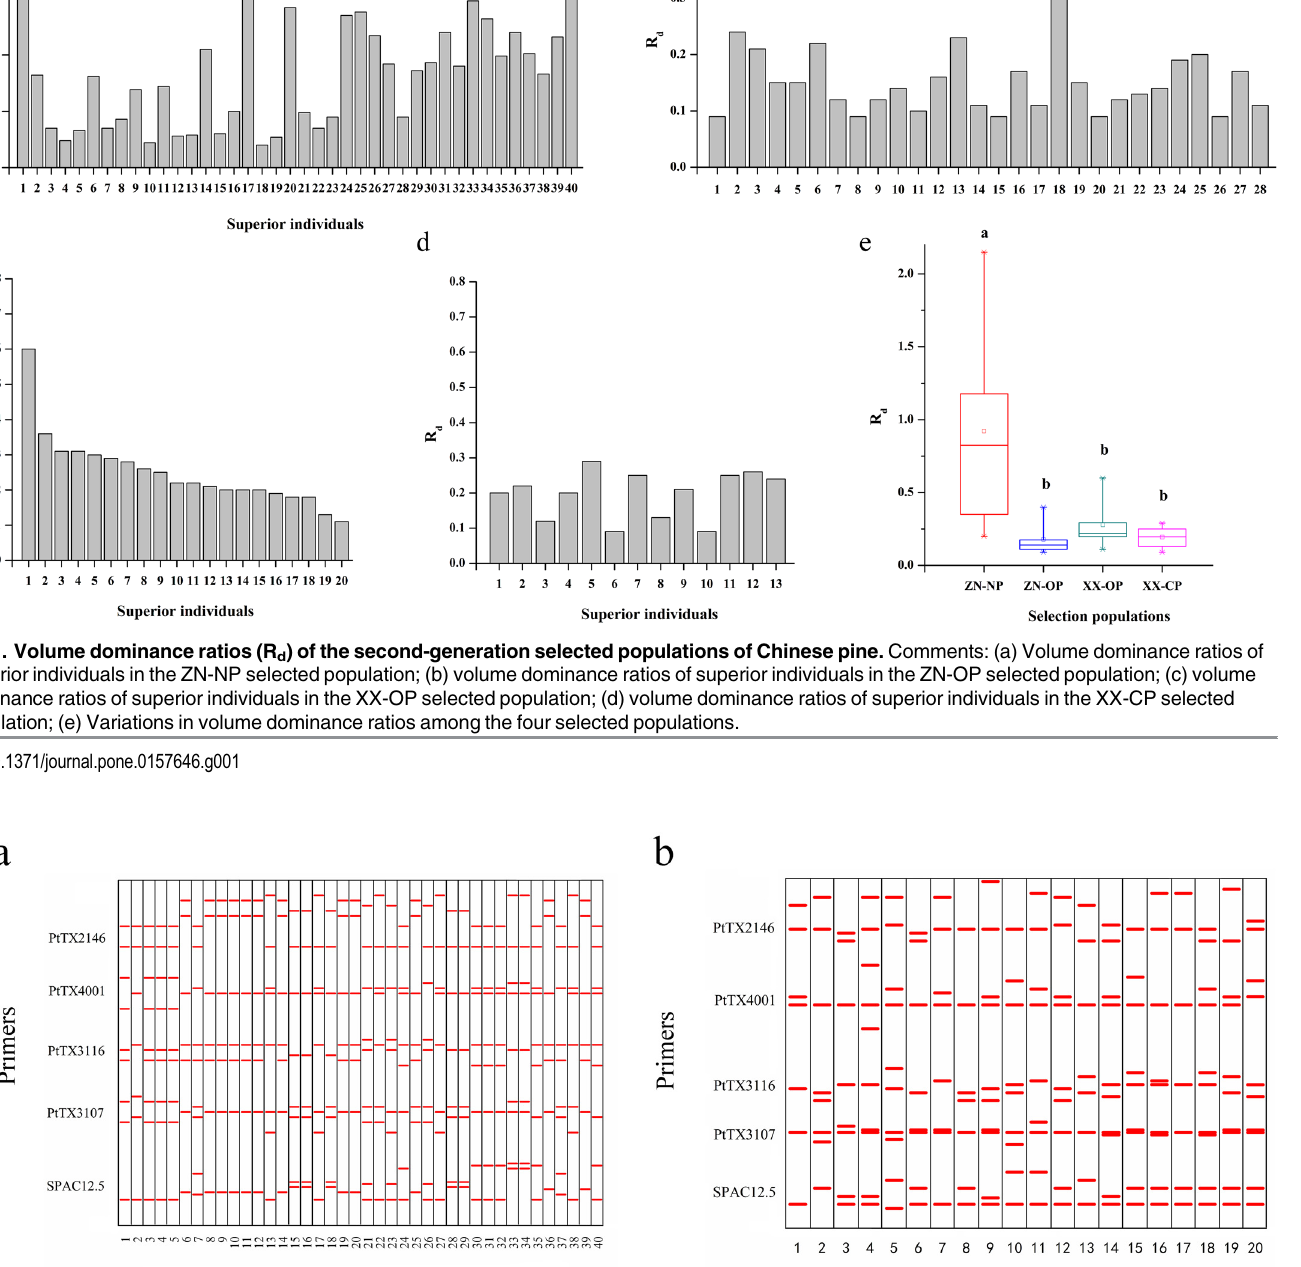
PLOS ONE | DOI:10.1371/journal.pone.0157646 June 16,